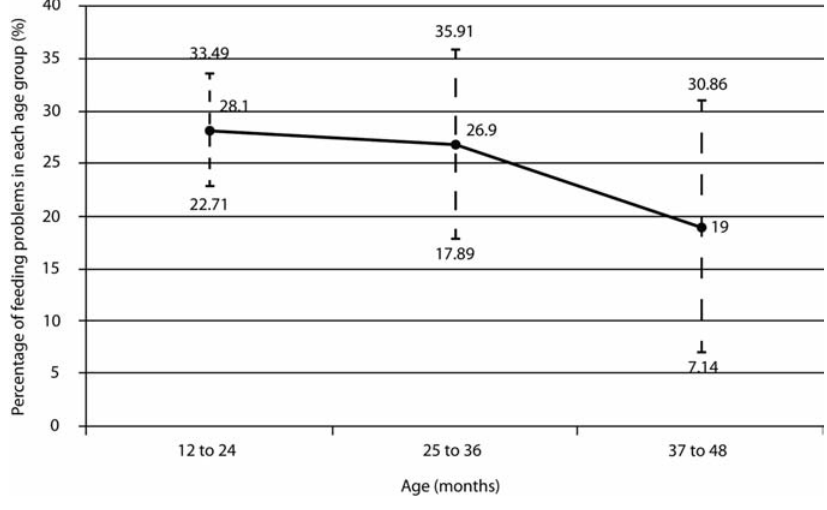
Figure 1. Prevalence of distribution of feeding problems in each age